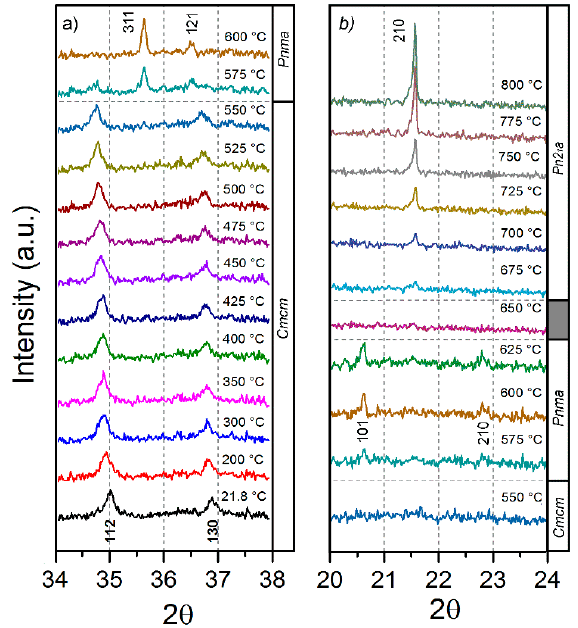
Figure 6. In situ X-ray powder diffraction patterns of LCP- Cmcm (PO): ( a ) Temperature range from 21.8 to 600 °C showing the transition from the Cmcm to the Pnma polymorph. The 2 θ range is from 34° to 38° where the main reflection (112) of LCP- Cmcm is observed; ( b ) Temperature range from 550 to 800 °C in the 2 θ range from 20° to 24°. The transition from the Pnma to the Pn 2 1 a modification is evident from the disappearance of the Pnma (101) and (210) reflections and the emergence of the Pn 2 1 a (210) reflection.